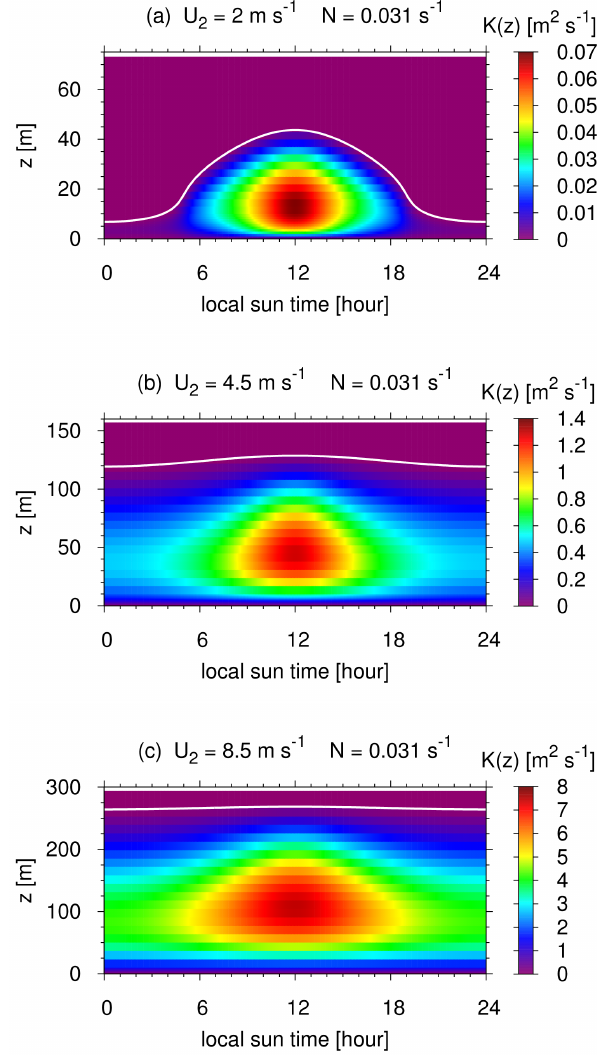
Fig. 3. Profiles and their diurnal variations of vertical diffusivity in the atmosphere prescribed by assuming N = 0 . 031 s − 1 and U 2 = 2 ms − 1 (a) , 4.5 ms − 1 (b) and 8.5 ms − 1 (c) . The white line in each graph indicates the level of Z ABL , above which the vertical diffusion is assumed to be controlled by molecular diffusion for gases or by Brownian diffusion for aerosols.